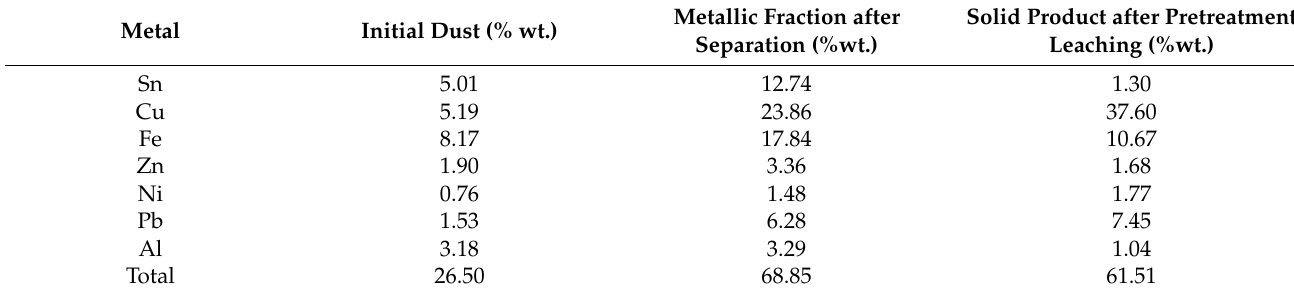
Table 1. Chemical composition of the dust before and after separation and the pretreatment step. Metal Initial Dust (% wt.)